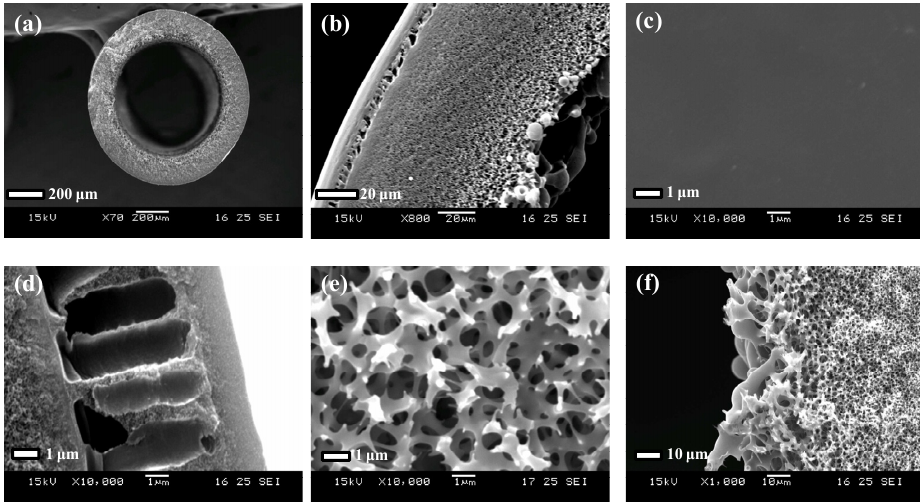
Figure 1. SEM images of the polybenzimidazole (PBI)/polyethersulfone (PES) membrane: ( a ) the cross section; ( b ) an enlarged cross section; ( c ) the outer PBI surface; ( d ) the outer PBI selective layer; ( e ) the middle PES transit layer; and ( f ) the inner PES support layer.